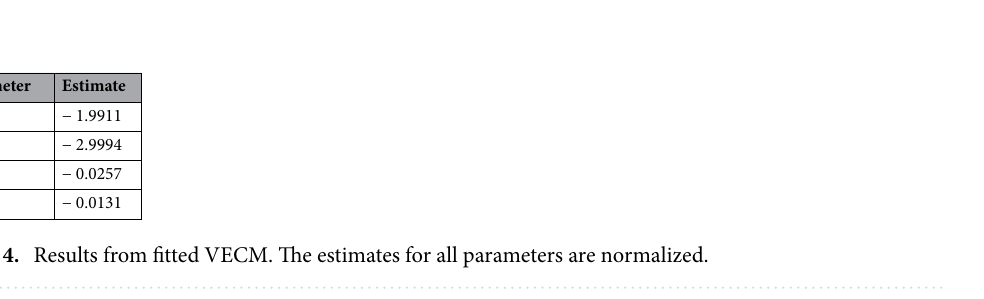
Table 3. Results from fitted VECM. Results denoted with an asterisk are statistically significant at a significance level of 0.05. The estimates for α 1 and α 2 are normalized.